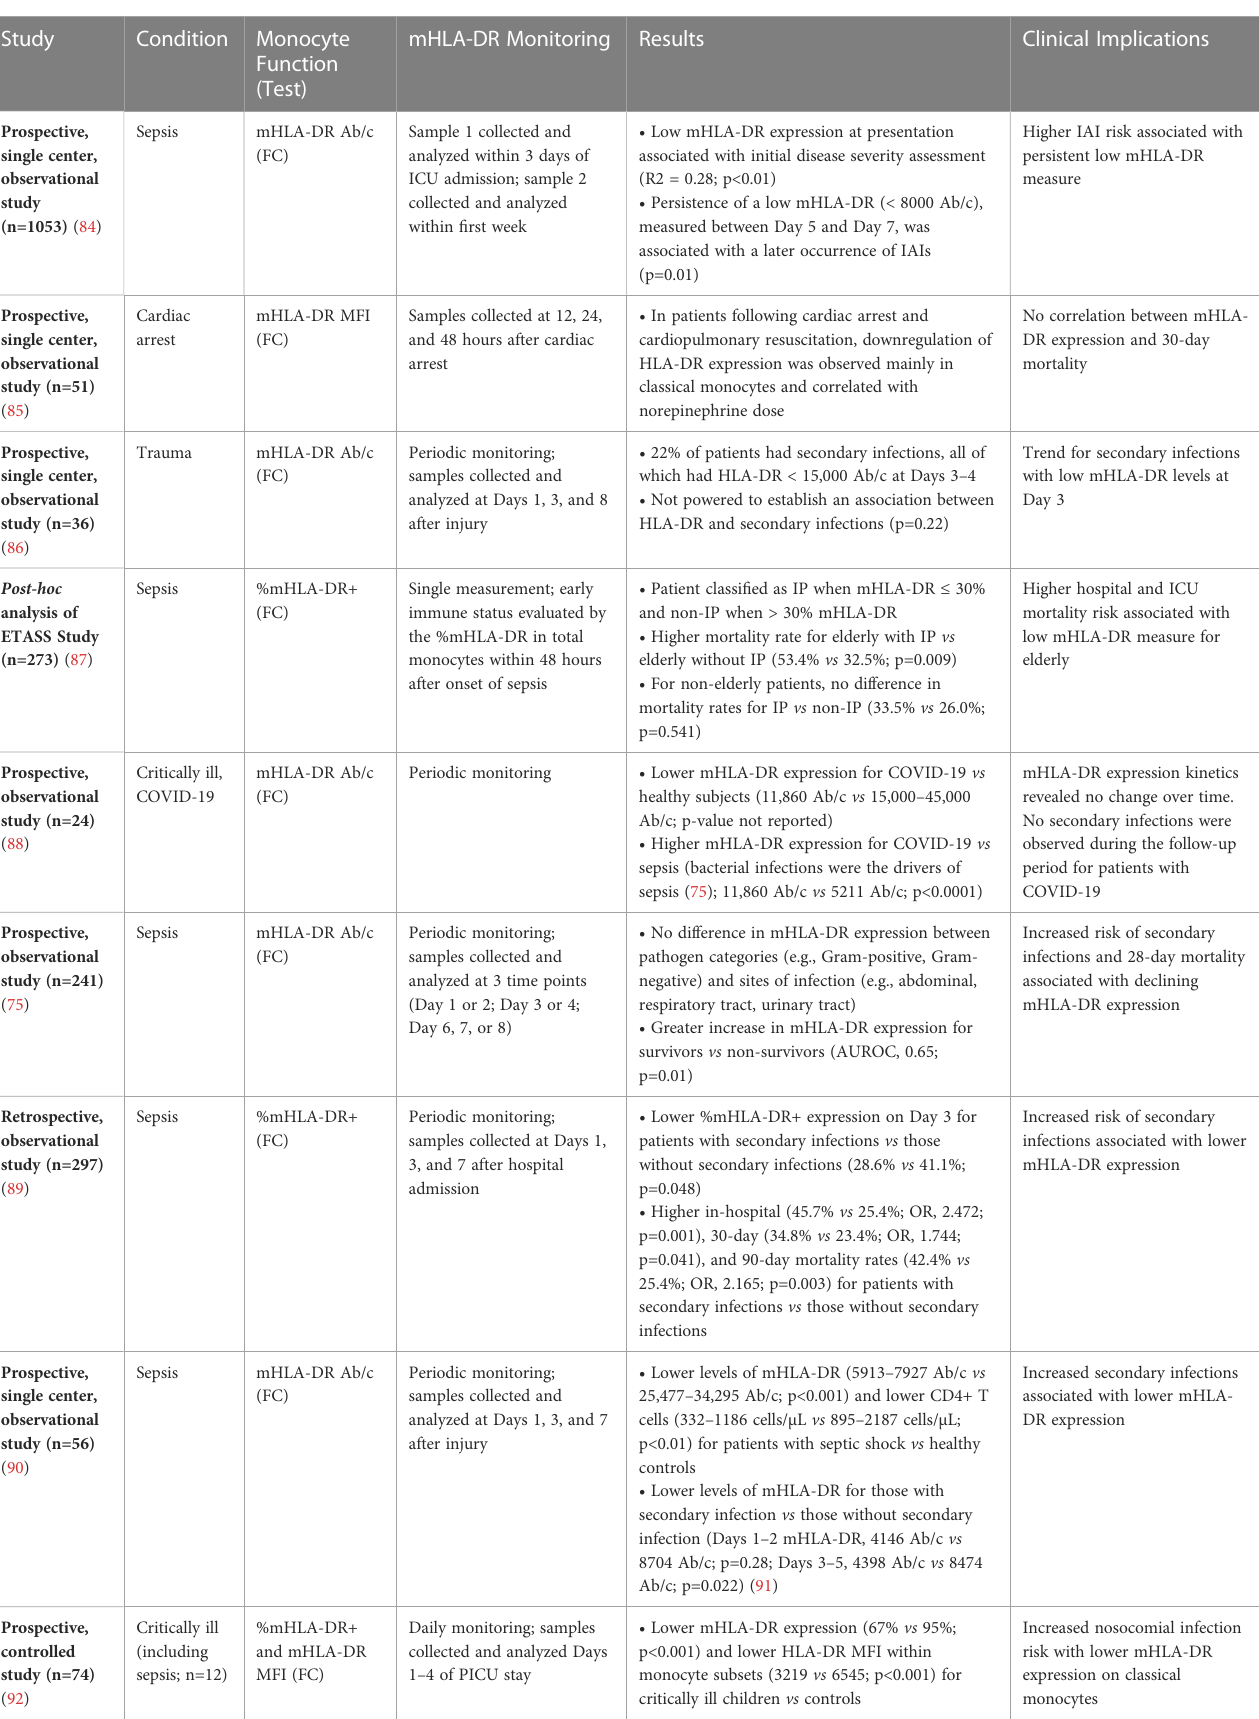
TABLE 1 Studies connecting monocyte HLA-DR to clinical